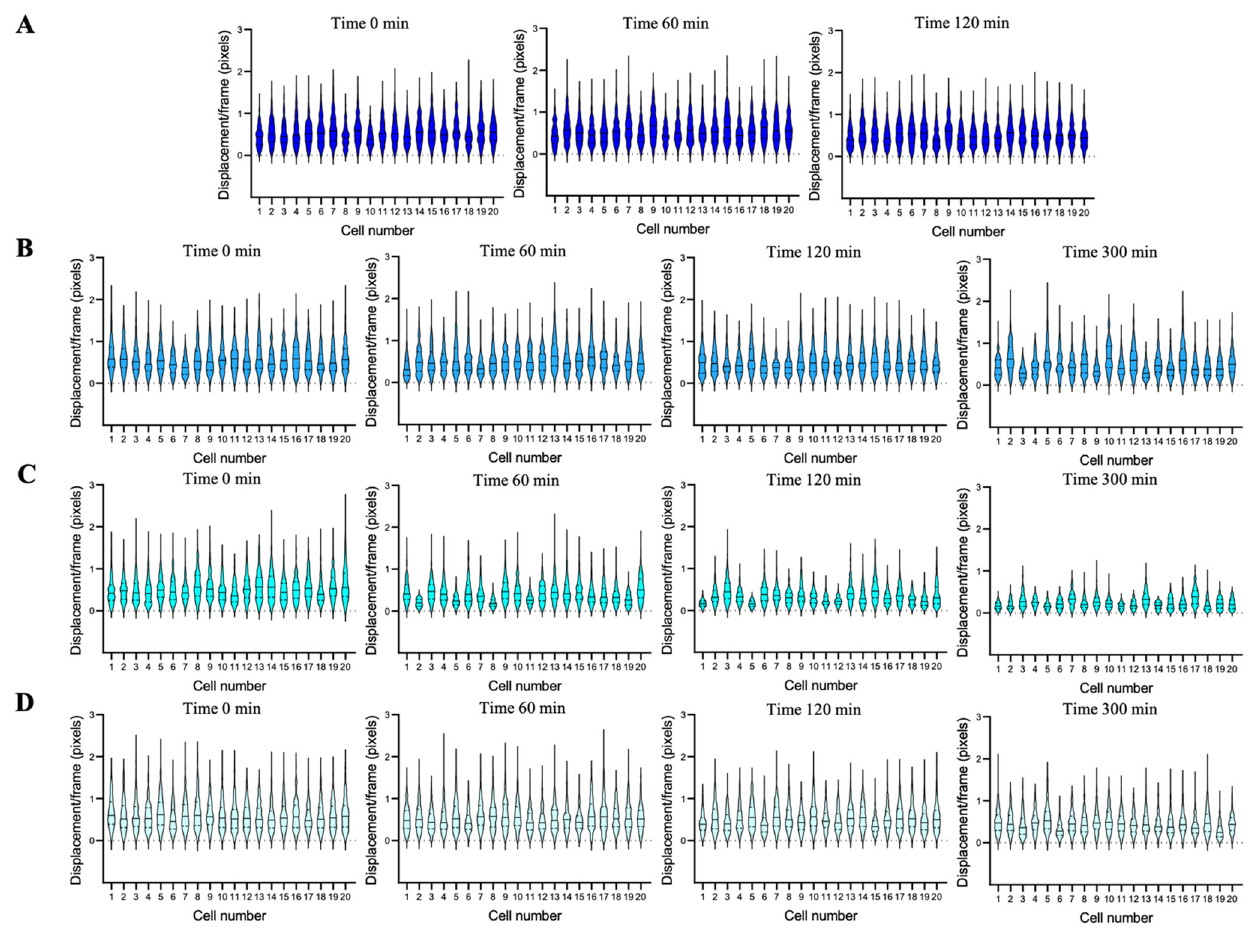
Figure 18. The displacement distribution for 20 single cells of C. albicans DSY1024 strain displayed in violin plots during ( A ) 2 h of growth in a YPD medium (control) and during 5 h of caspofungin treatment with ( B ) 0.5 µg/mL, ( C ) 1 µg/mL, and ( D ) 100 µg/mL.